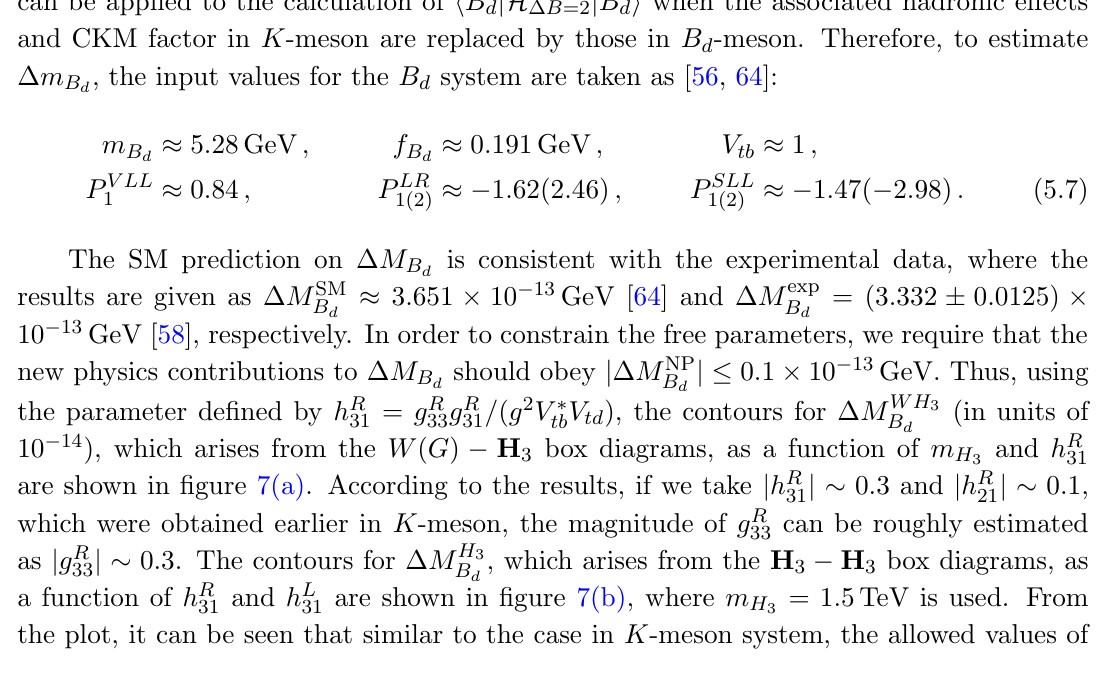
and h R , where m H = 1 : 5 TeV is 21 21 3